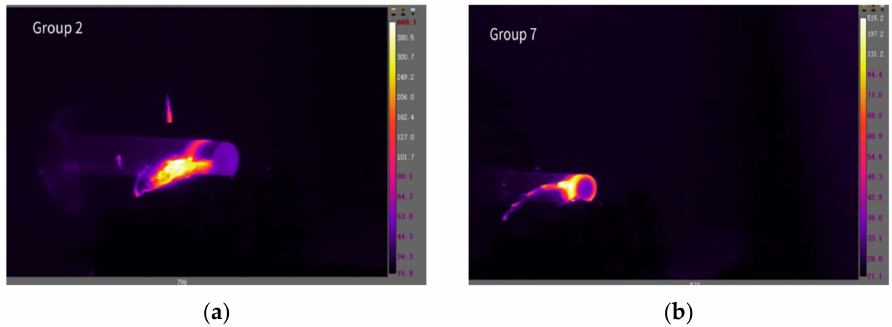
Figure 10. Temperature field nephogram of cutting process: ( a ) group II cutting process; ( b )